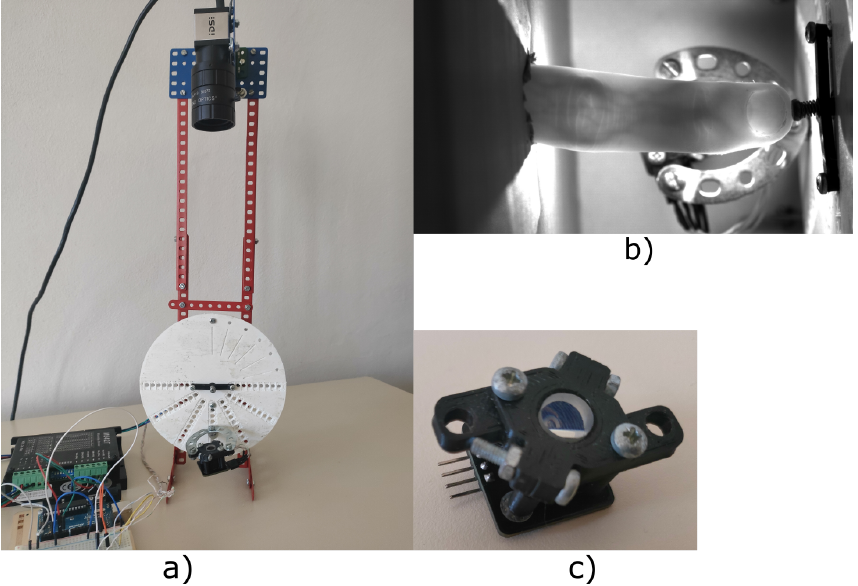
Figure 7. Test device ( a ) Image of the device without cover. ( b ) Image from the device with alignment light and finger. ( c ) Laser diode with powell lens to illuminate the